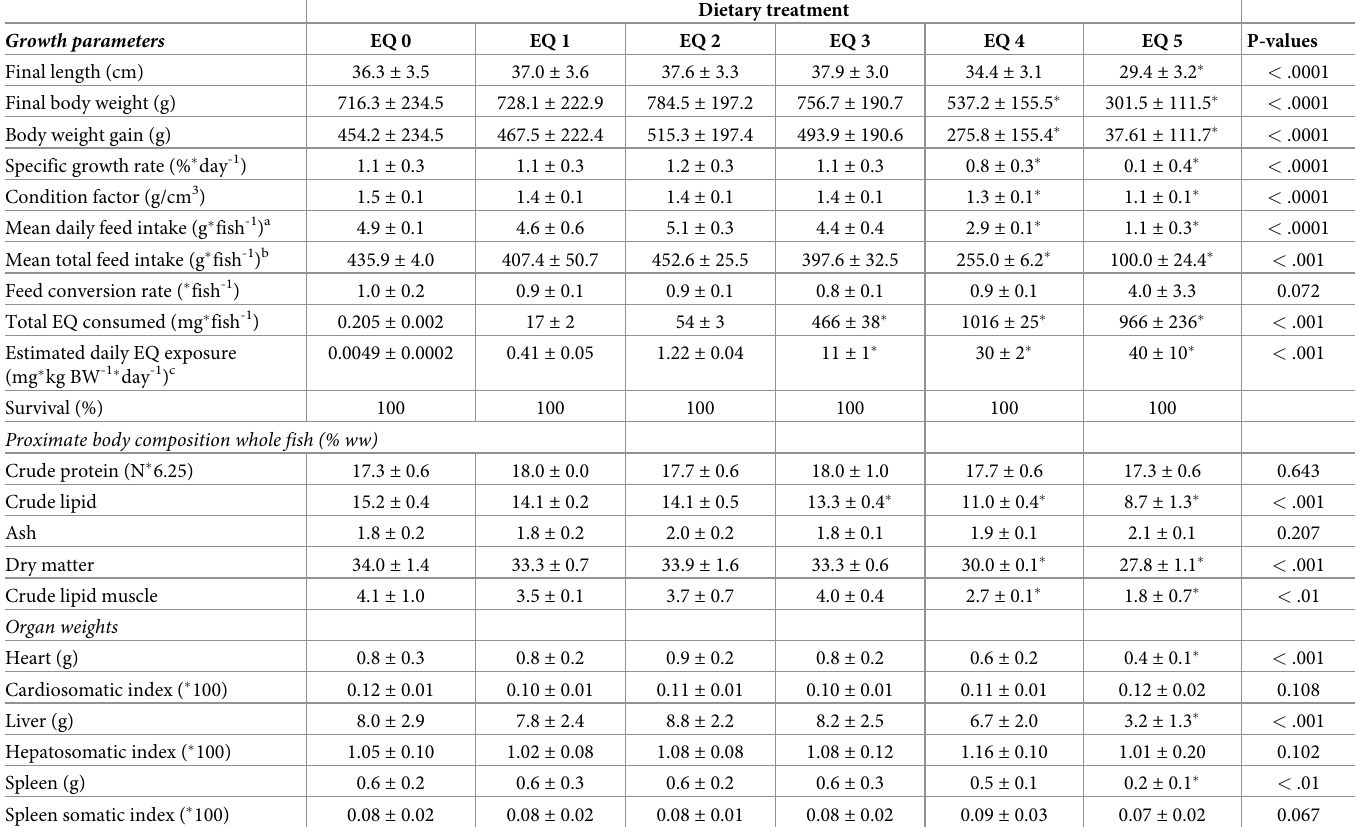
Table 3. Growth parameters, feed intake, exposure estimation, survival, proximate body composition and organ weights of Atlantic salmon ( Salmo salar L.) exposed to graded levels of EQ through their diet for 90 days.